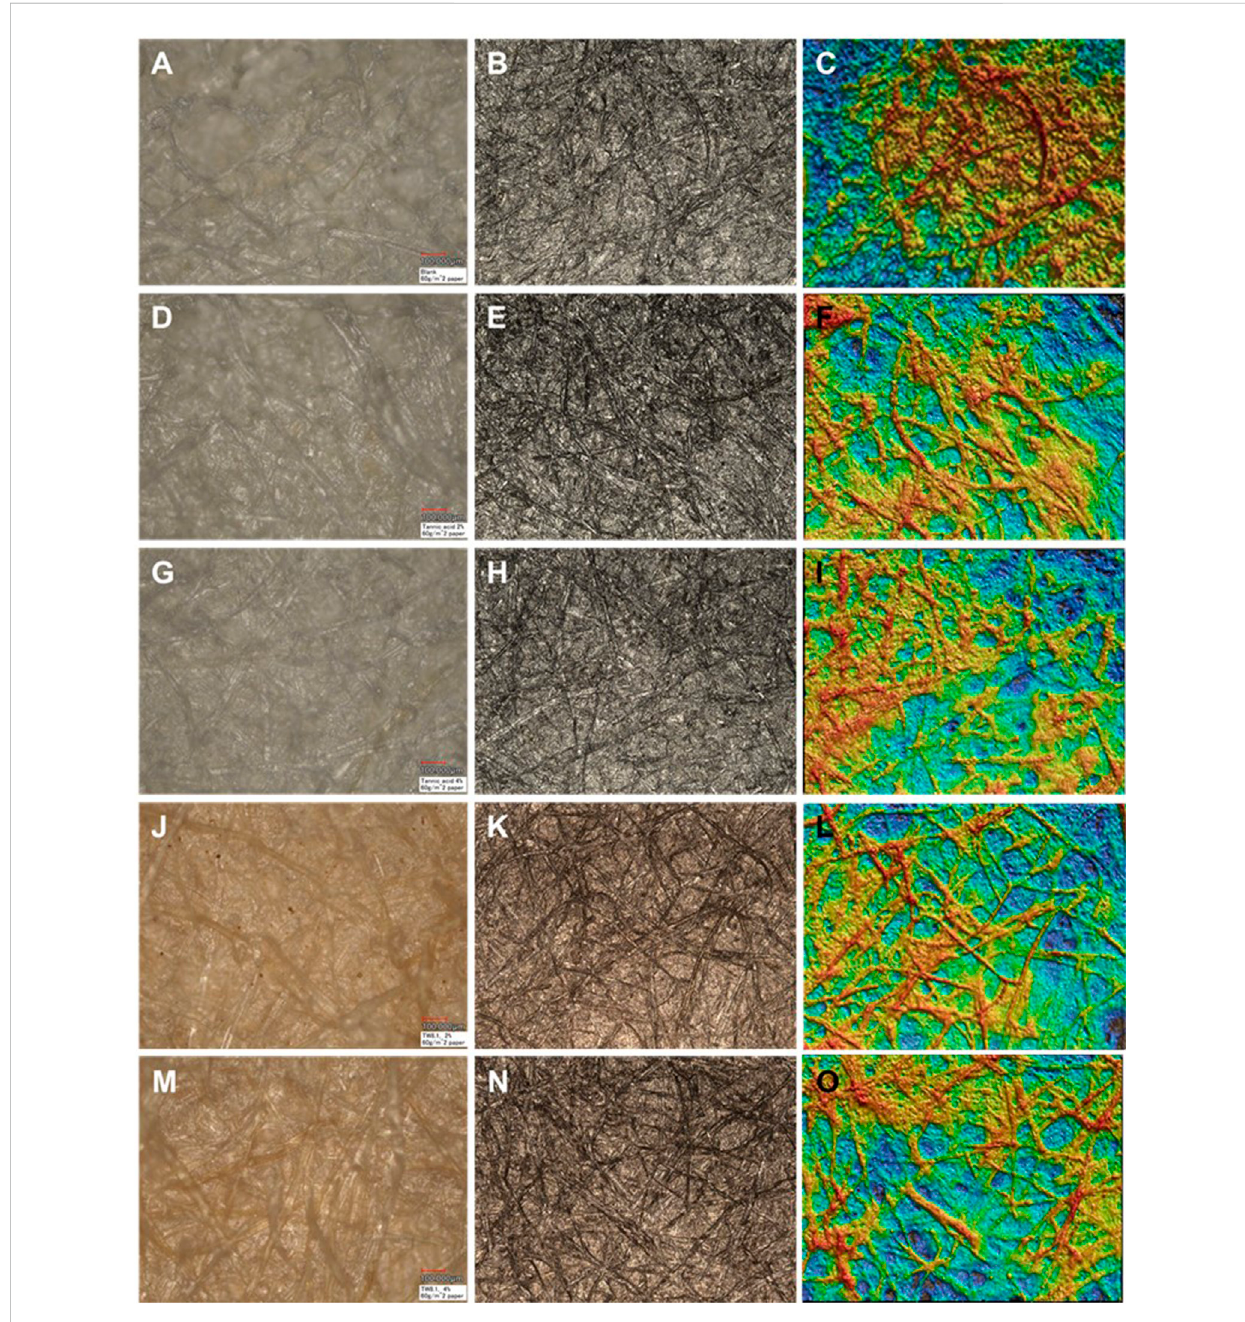
Laser microscopy of 60 g/m 2 handsheets: control (A – C) , tannic acid (TA; (D – F) 2%; (G – I) 4%), and TW extract ( (J – L) 2%; (M – O) 4%). The left side column of the sub fi gures represents opticalmicrographs; the center columns of the sub fi gures represent the laser image with color of the Extended Depth of Focus program; and the right-hand column of the sub fi gures represents the laser images as a 3D